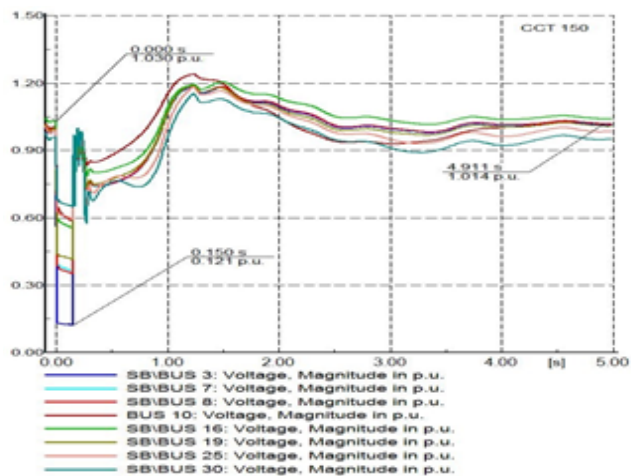
Fig. 16. Voltage Plot during fault on ‘Line 3_1’, cleared by switching off the line after 150ms. (With HVDC line).